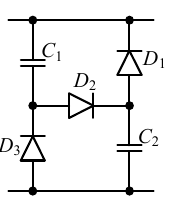
Figure 1. The unidirectional step-down switched-capacitor cell [31].